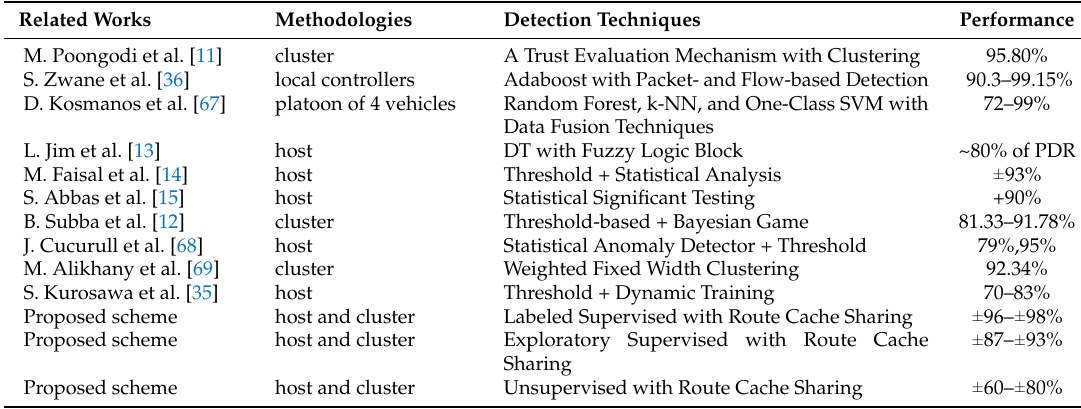
Table 8. A comparison of the proposed system with